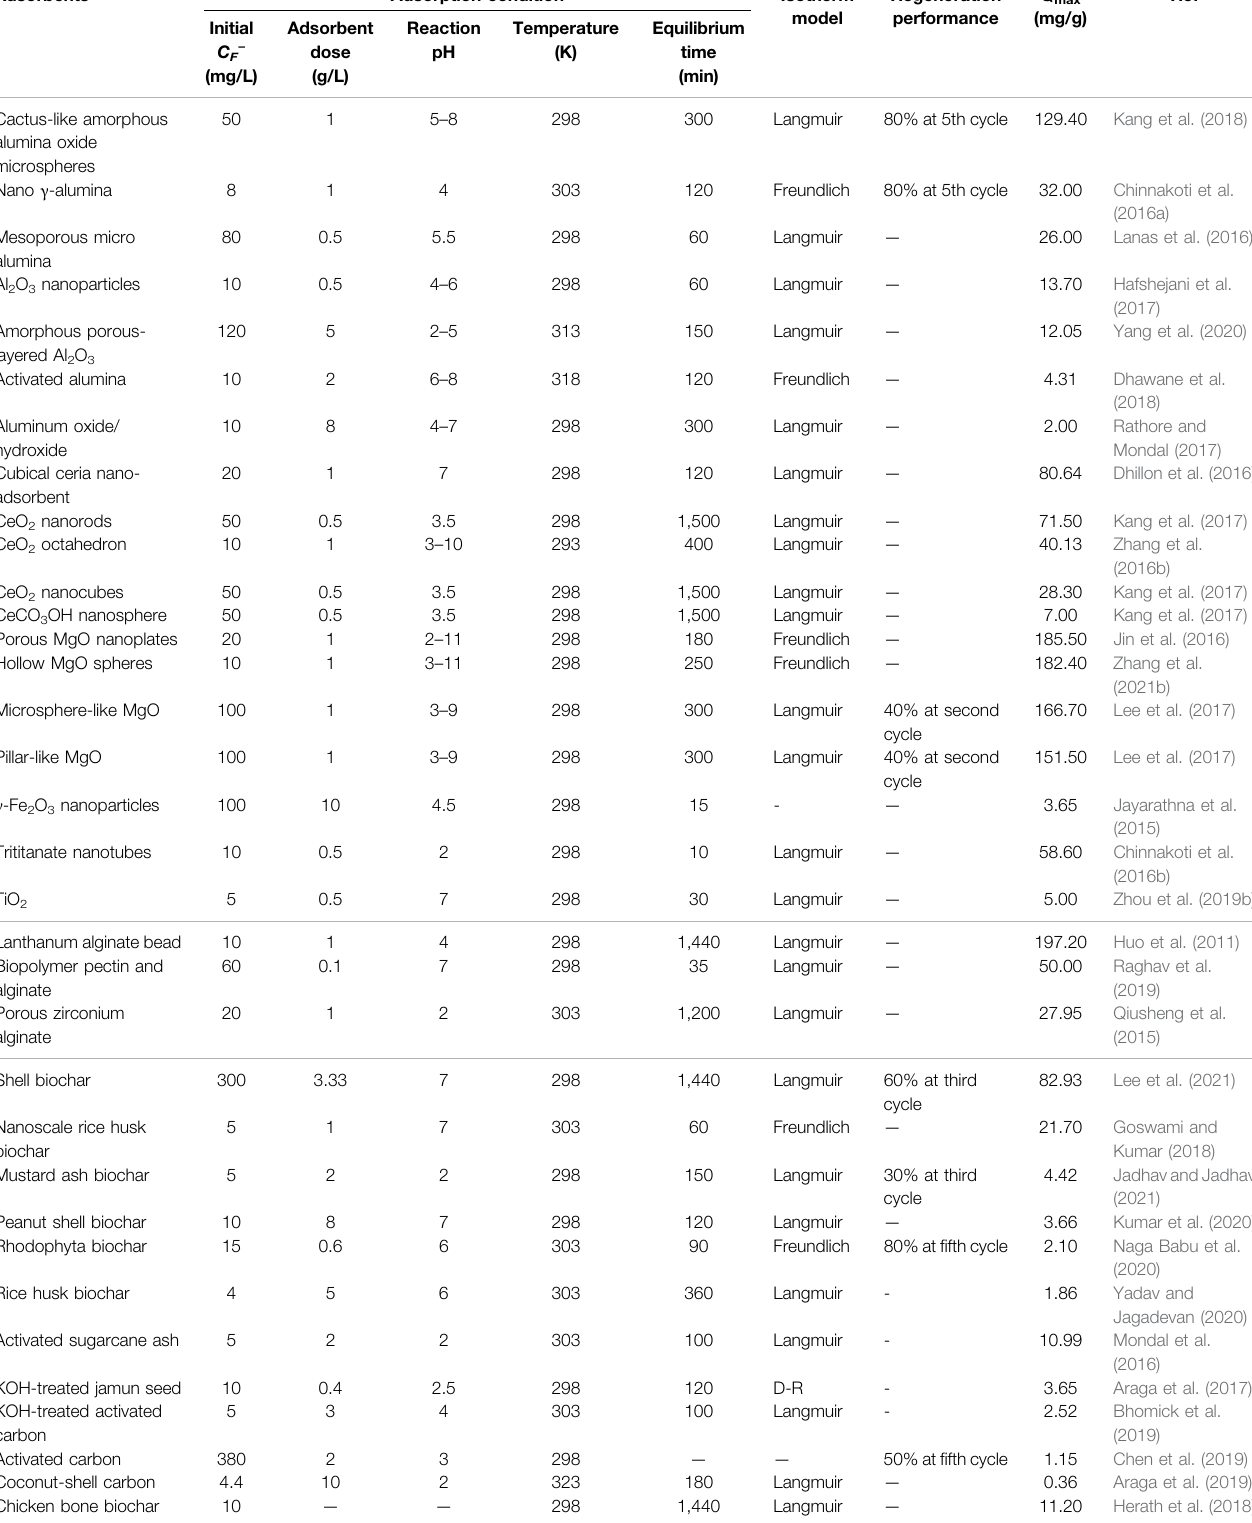
TABLE 2 | Adsorption conditions and performance of fl uoride by four conventional